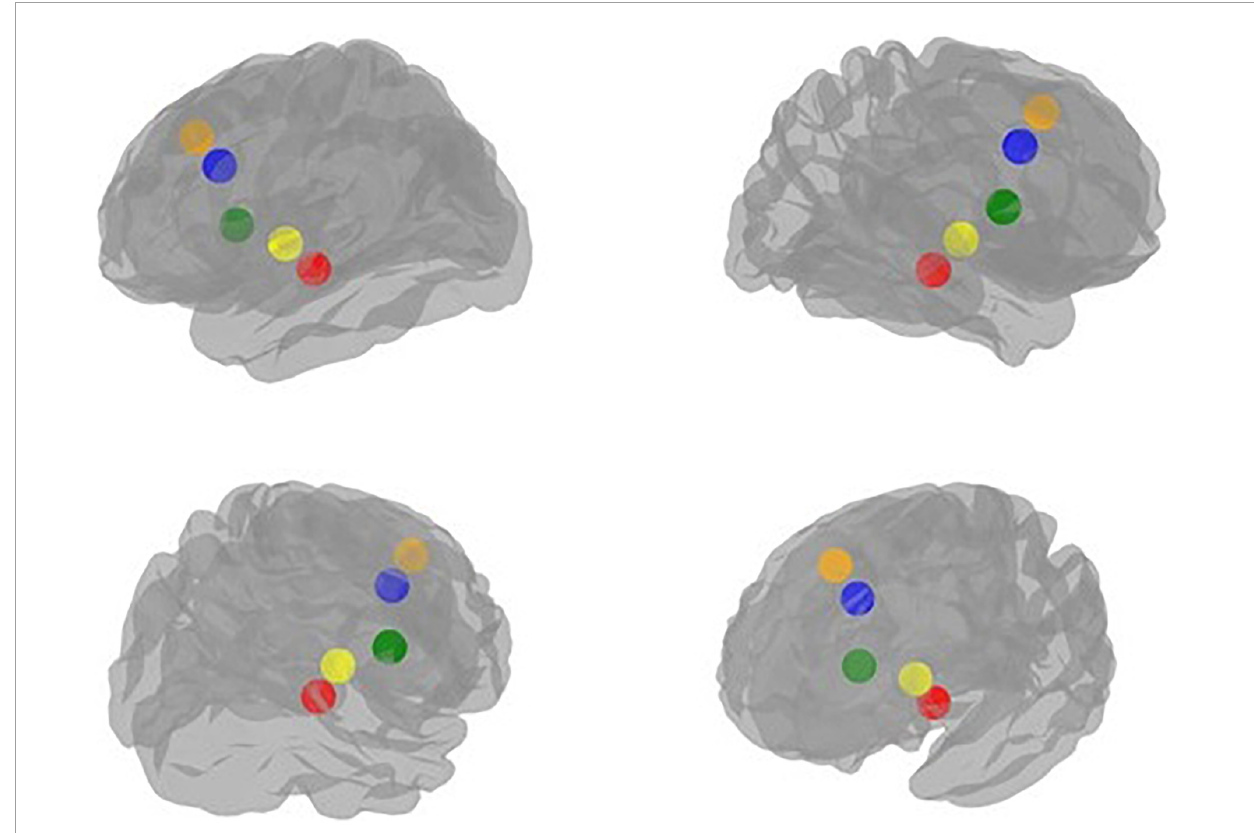
FIGURE2 Visualization of the regions of interest (ROIs) implicated in the neural processing of emotion regulation in peer-victimized adolescents: red: Amygdala, blue: Anterior cingulate cortex (ACC), green: Anterior insula, yellow: Posterior insula, orange: Medial prefrontal cortex (mPFC).